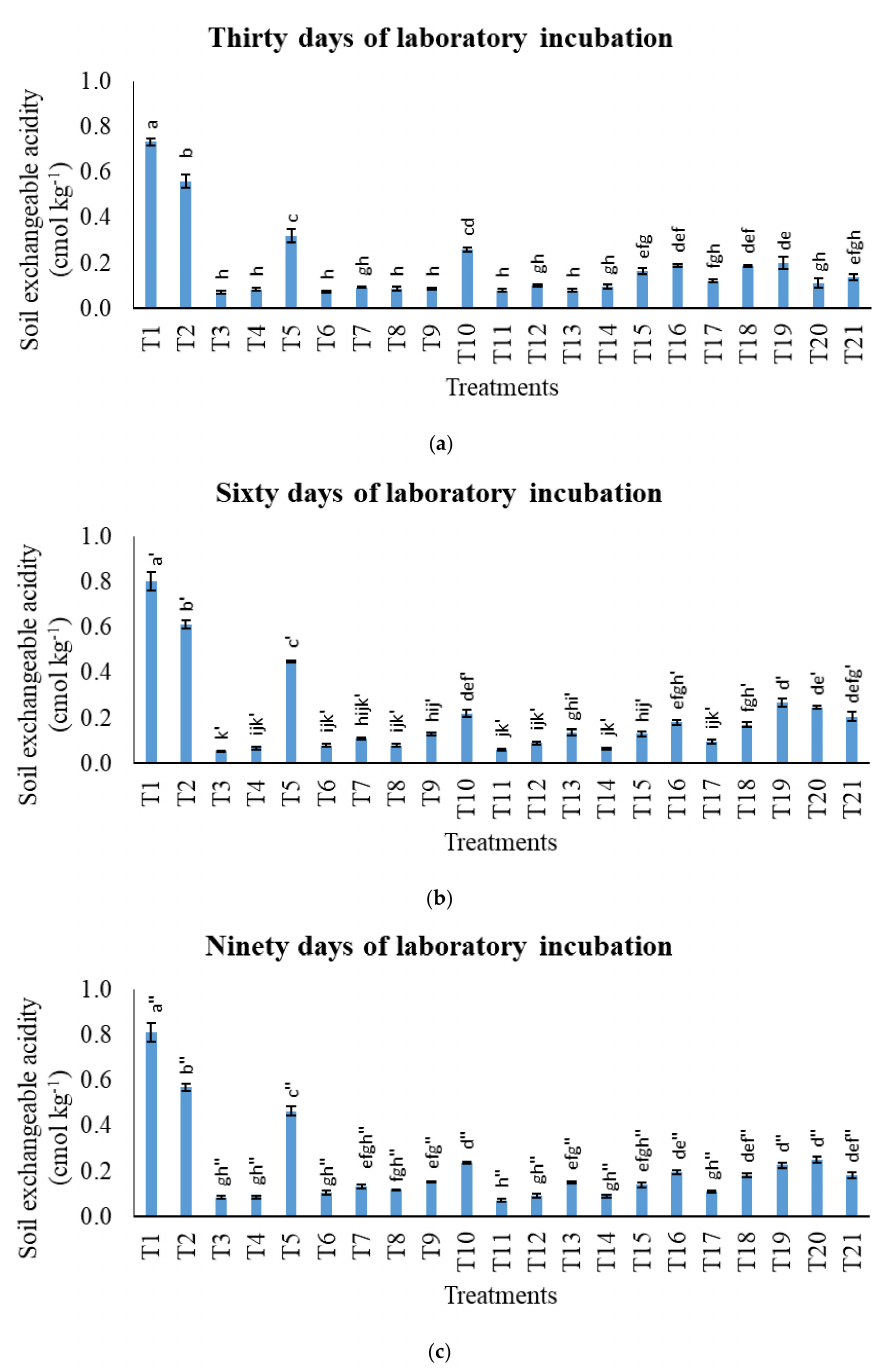
Figure 2. Effects of treatments on soil-exchangeable acidity over ( a ) thirty; ( b ) sixty; and ( c ) ninety days after incubation.T1: soil control, T2: conventional practice, T3: muriate of potash + 100% charcoal + 100% sago bark ash, T4: muriate of potash + 100% sago bark ash, T5: muriate of potash + 100% charcoal, T6: muriate of potash + 80% charcoal + 80% sago bark ash,